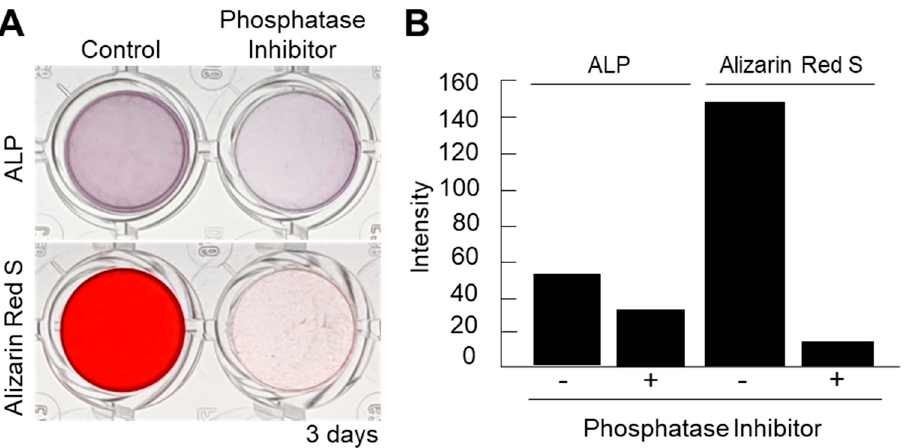
Figure 4. ( A ) Inhibition of ALP activity using a phosphatase inhibitor cocktail partially suppressed the ALP activity but completely blocked the mineralization of the cell nanofragments, as determined by ARS staining. Alpha-MEM was used as the vehicle in the inhibition assay. ( B ) Quantitative analysis of ALP and ARS staining performed with ImageJ. A blank well was used as control for the image